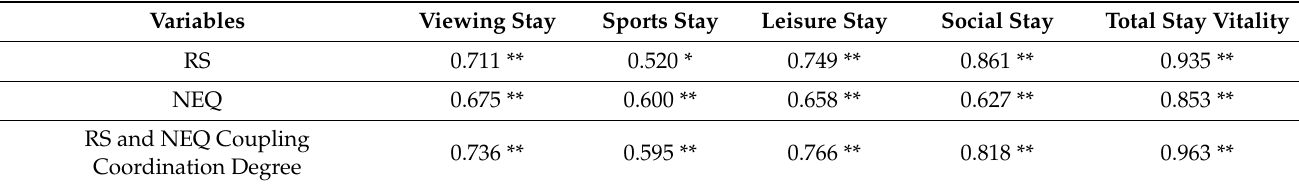
Table 7. Correlation analysis of waterfront spatial characteristics and total stay